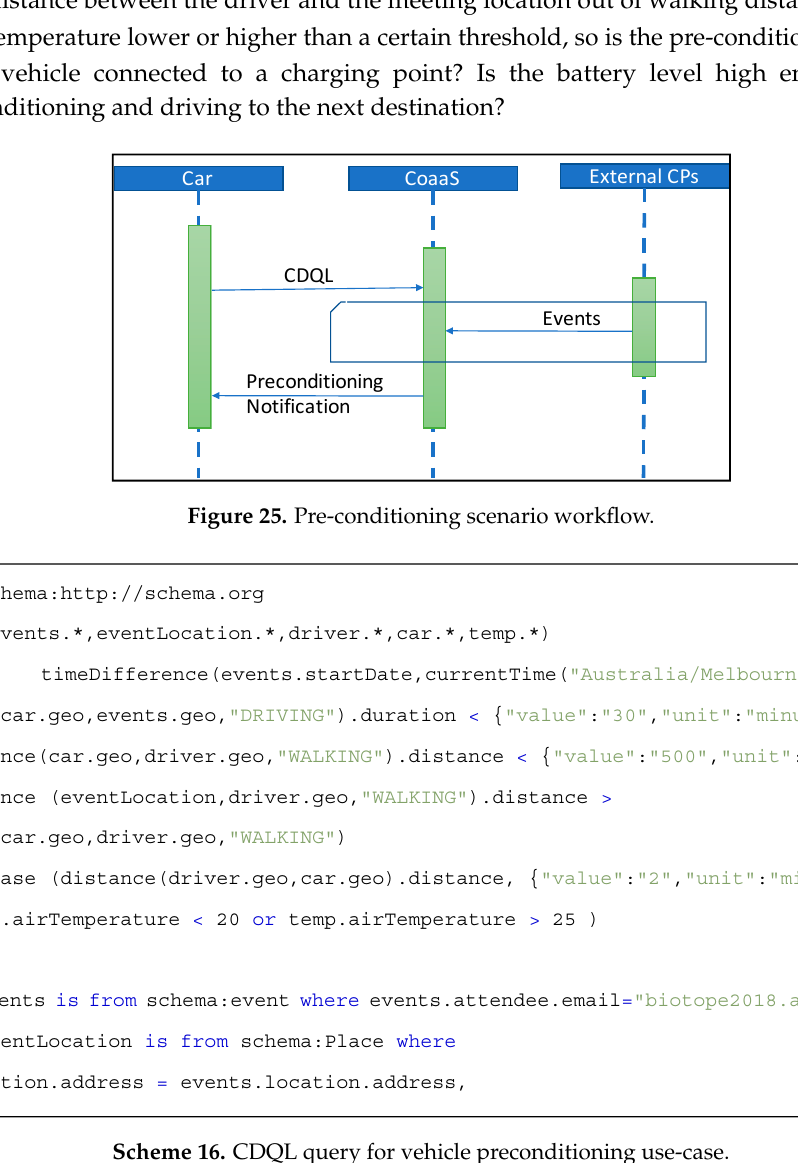
Scheme 16. CDQL query for vehicle preconditioning use-case.